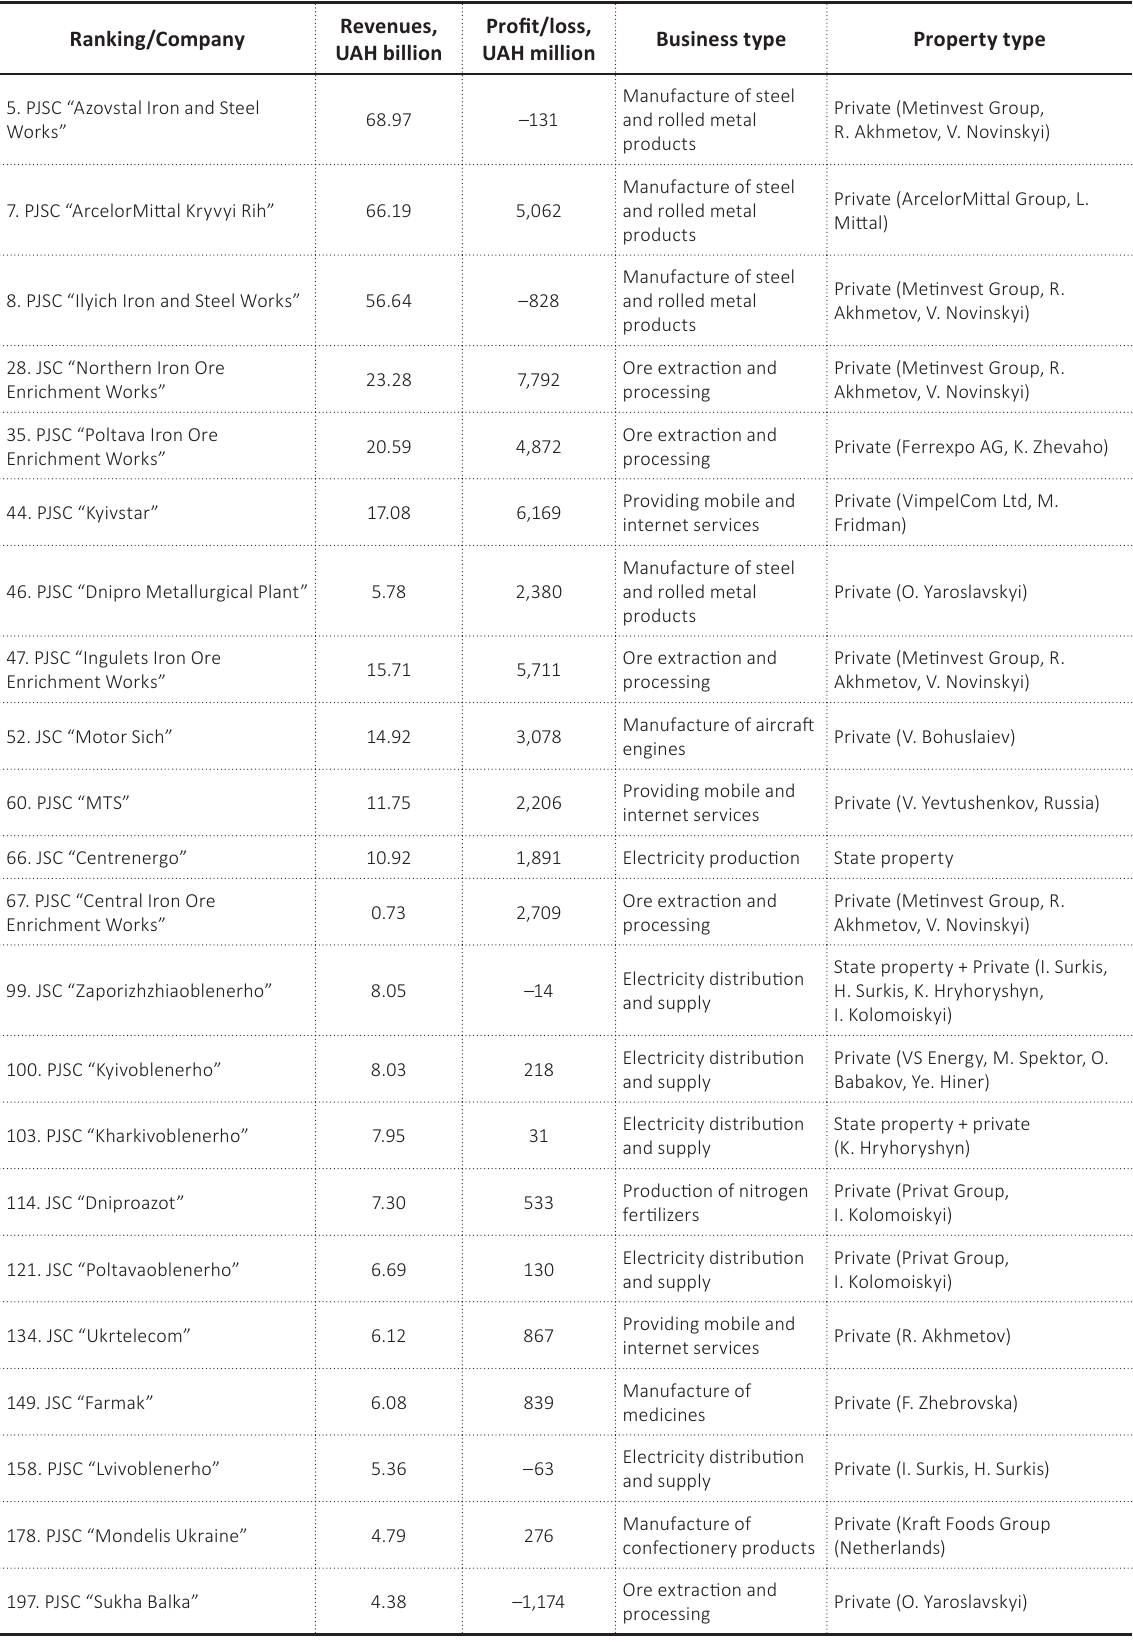
Table 1. Companies in the top 200 largest revenue-producing companies of Ukraine in 2017